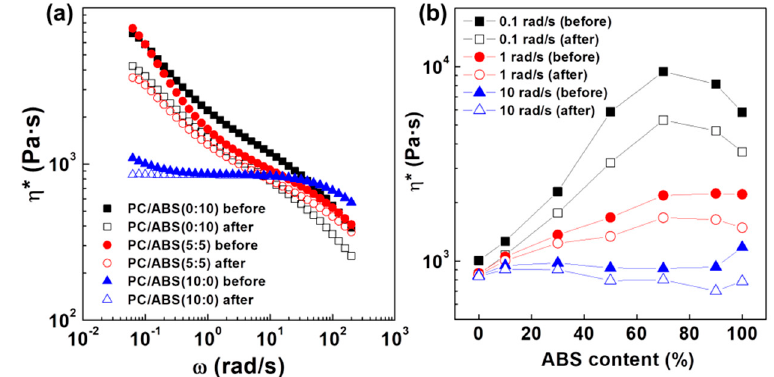
Figure 4. Change of viscosity of PC/ABS blends before and after strain sweep applied sequence mode; ( a ) viscosity curve and ( b ) change of complex viscosity with increasing ABS content.